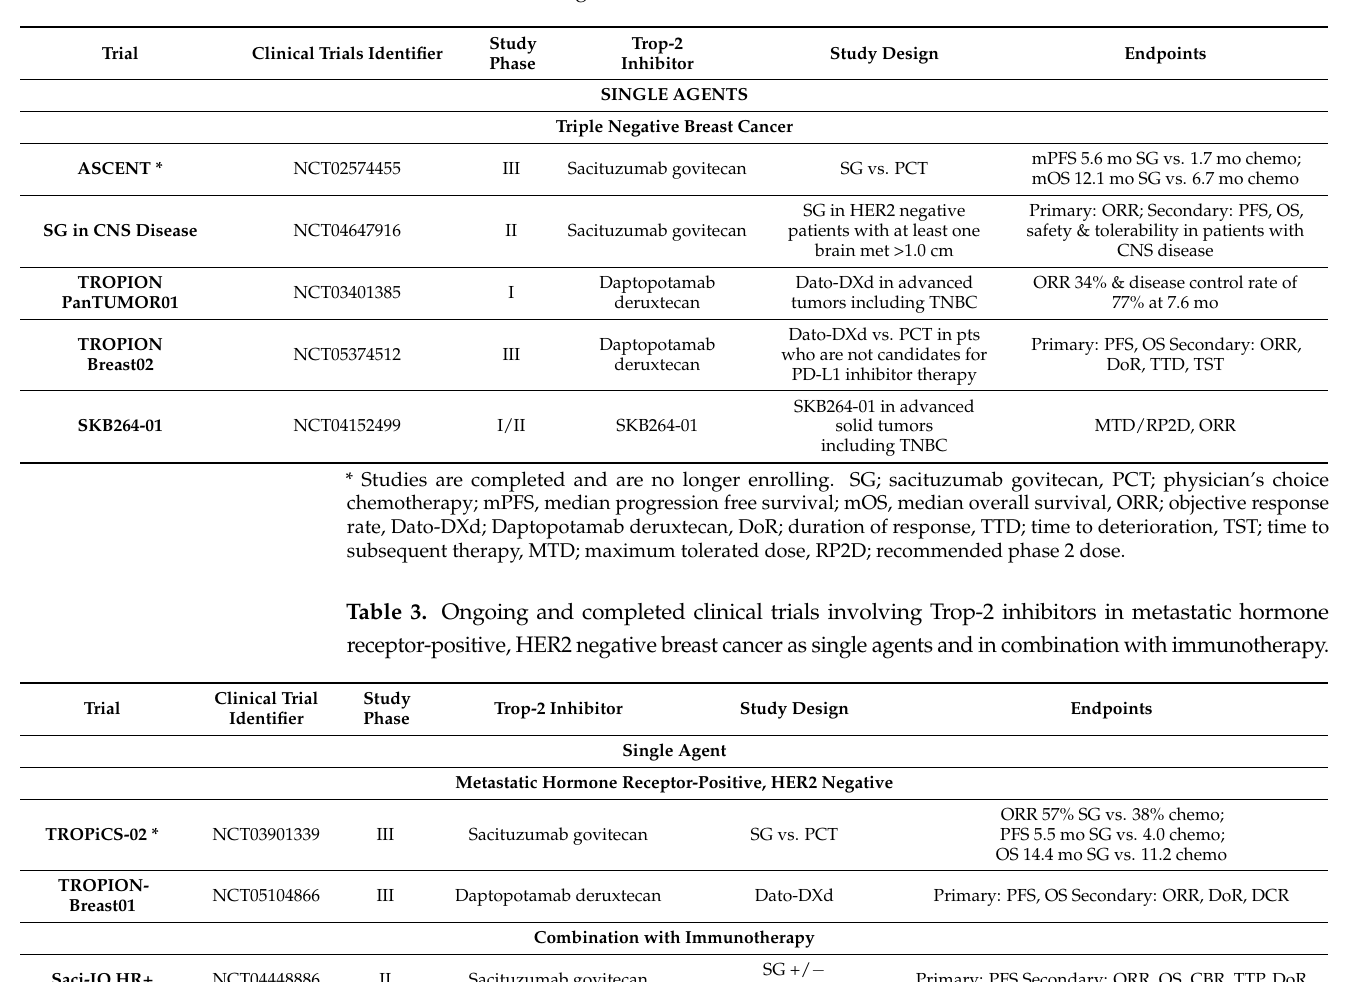
Table 2. Ongoing and completed clinical trials involving Trop-2 inhibitors as single agents in the metastatic TNBC setting.